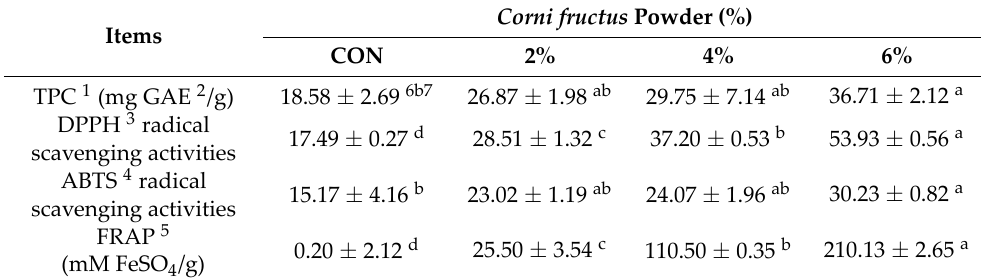
Table 5. Antioxidative activity of Yanggaeng treated with Corni fructus powder.